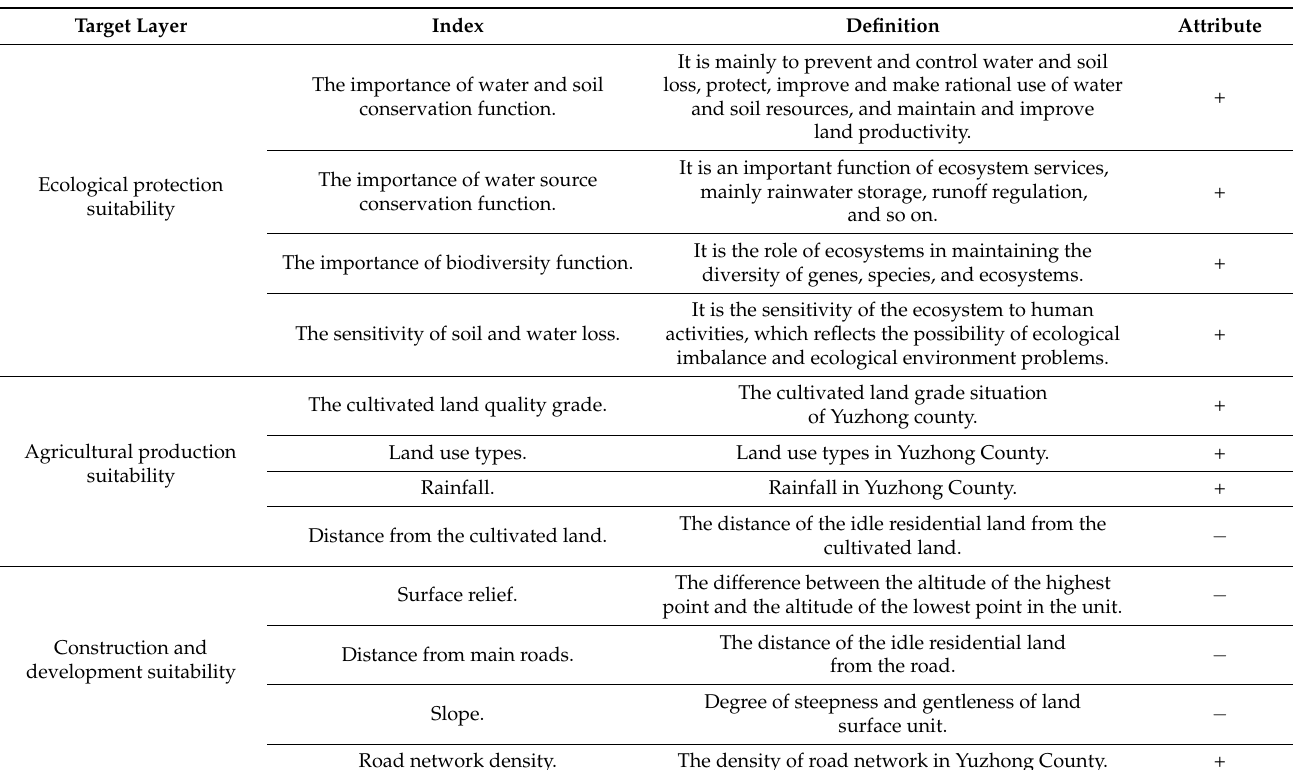
Table 2. Evaluation indicator system of the rural land